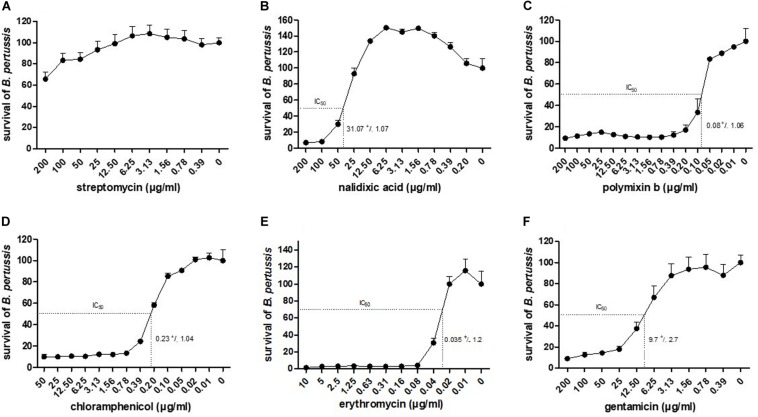
Dose-response curves to antibiotics and corresponding IC50. Indicated antibiotics at indicated concentrations were tested for growth inhibition on BPSM. After 16 h of incubation, RLU values are reported in percentages of growth relative to bacterial growth in the absence of antibiotics. The dose-response curves to streptomycin (A), nalidixic acid (B), polymixin b (C), chloramphenicol (D), erythromycin (E) and gentamicin (F) are represented as means of three independent experiments. The IC50 value of each antibiotic is indicated in the corresponding graph.